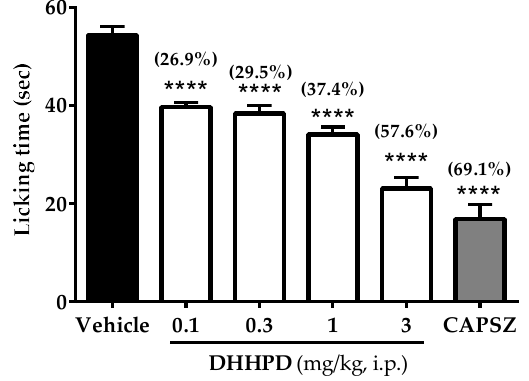
Figure 4 . Effect of DHHPD against capsaicin-induced paw licking test in mice. Each column denotes the mean ± SEM ( n = 6). The asterisks (*) represent the significance level as compared to the vehicle group, **** p < 0.0001 by one-way ANOVA followed by Dunnett’s post hoc test. Mice were administered with vehicle (10 mL/kg, i.p.), acetylsalicylic acid (ASA, 100 mg/kg, i.p.) and DHHPD (0.1, 0.3, 1 and 3 mg/kg, i.p.).